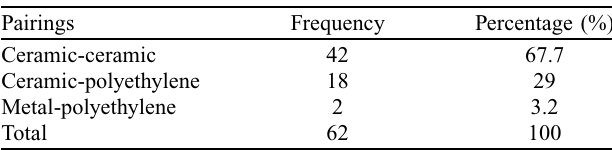
Table 2. Distribution of different pairings among patients who underwent MiniHip TM .